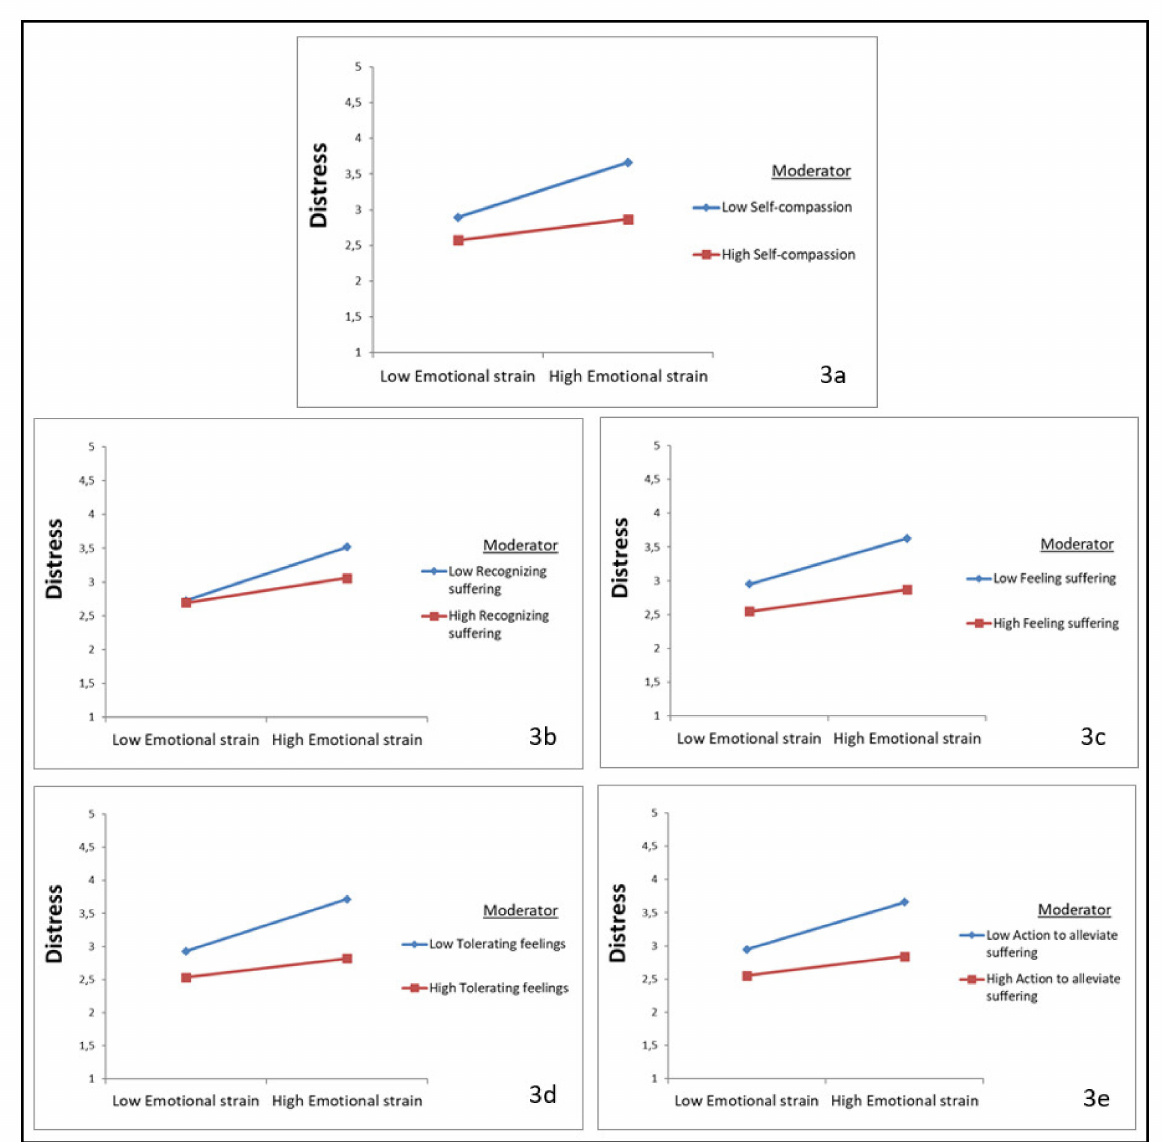
Figure 3. Plots of the interaction between emotional strain and self-compassion (and subscales) in predicting distress. ( a ) self-compassion as moderator; ( b ) Recognizing suffering as moderator; ( c ): Feeling suffering as moderator; ( d ) Tolerating feelings as moderator; ( e ) Action to alleviate